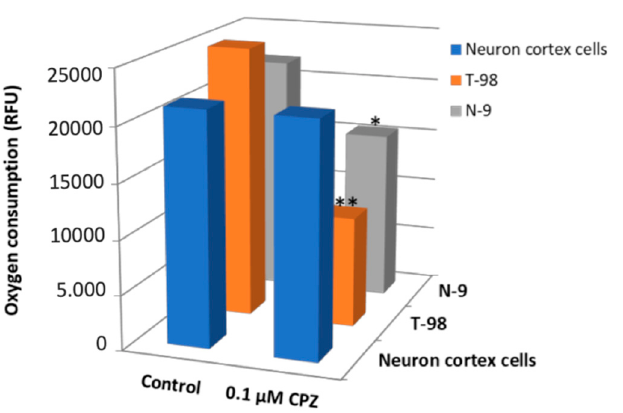
Figure 10. Oxygen consumption in T-98, N-9 and neuronal cortex cells treated with 0.1 μ M of CPZ for 24 h. Data are the mean ± S.E.M of five independent experiments. Significant differences were analyzed by a Student’s t-test. * p < 0.05, ** p < 0.01 glial compared to neuronal cells. RFU: relative fluorescence units.